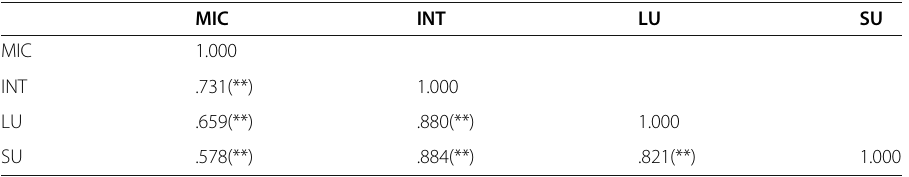
Table 1 Correlation between rating components (Spearman ’ s rho)